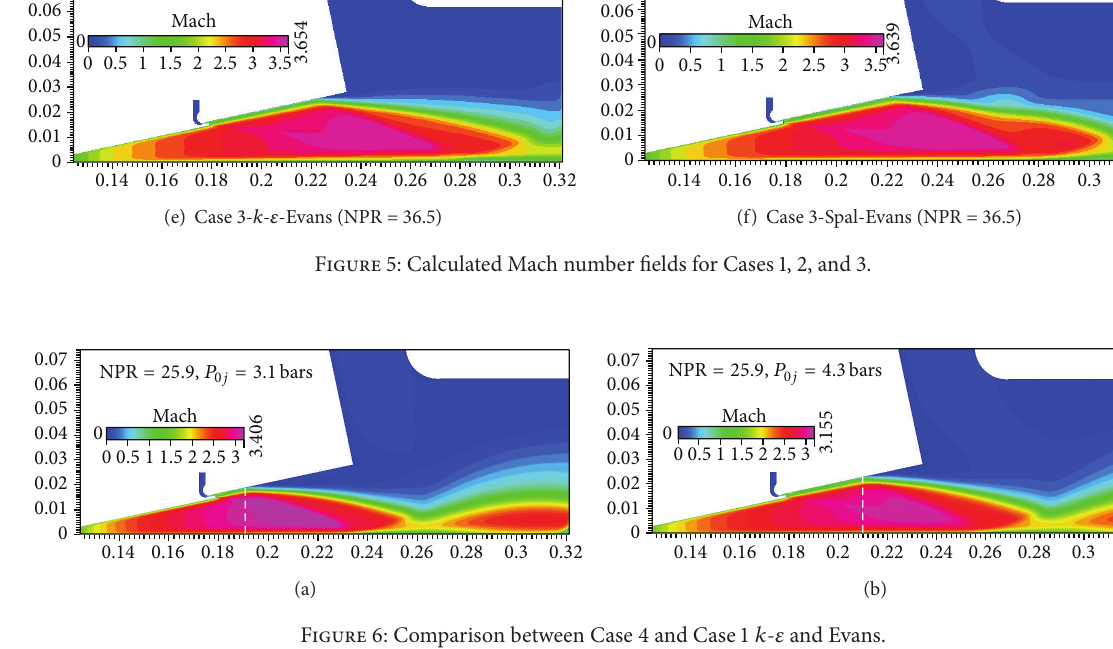
Figure 6: Comparison between Case 4 and Case 1 𝑘 - 𝜀 and